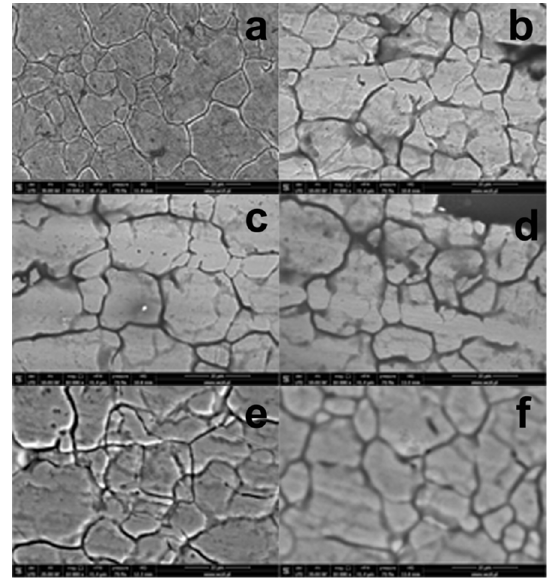
Figure 1. Scanning electron microscope (SEM Hitachi, SU3500) image of ( a ) 304 stainless steel after acetone and hot 10% KOH solution treatment; ( b ) sample R1; ( c ) sample R2; ( d ) sample R3; ( e ) sample R4; ( f ) sample R5 at magnification 10k x.